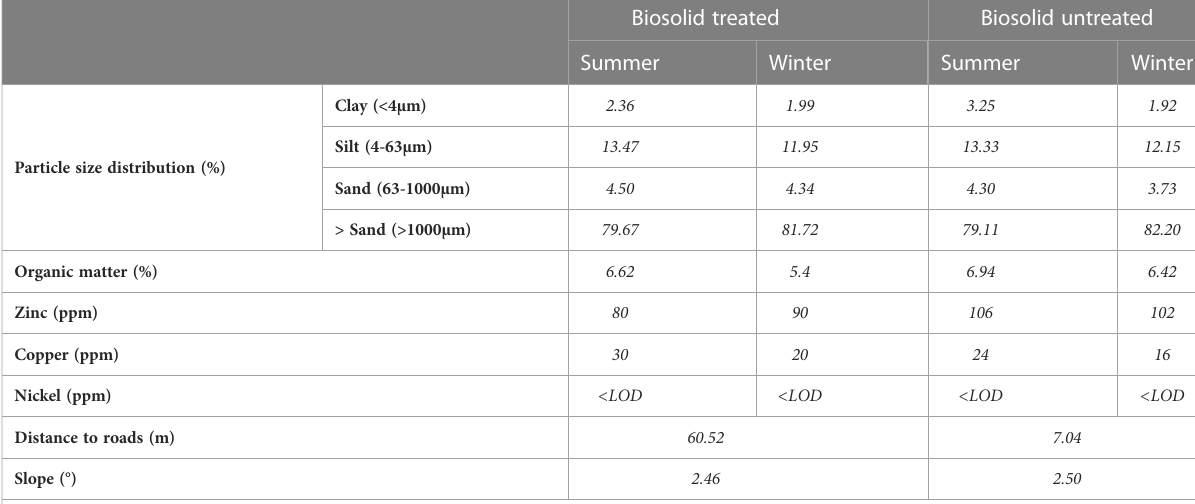
TABLE 1 Mean covariate measurements for soil characteristics and geographical